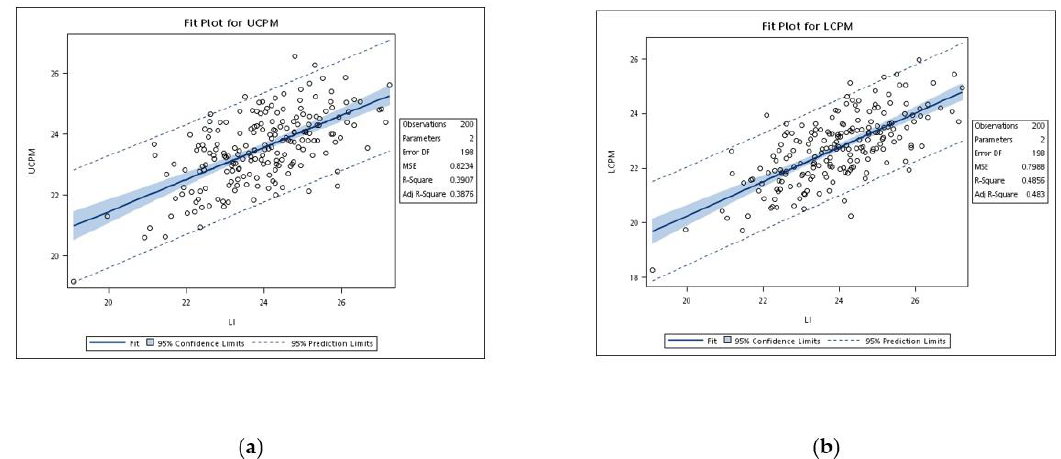
Figure 2. ( a ) Regression of actual tooth sizes of the upper canines and premolars and the sum of mandibular incisors for both genders; ( b ) regression of actual tooth sizes of lower canines and premolars and the sum of mandibular incisors for both